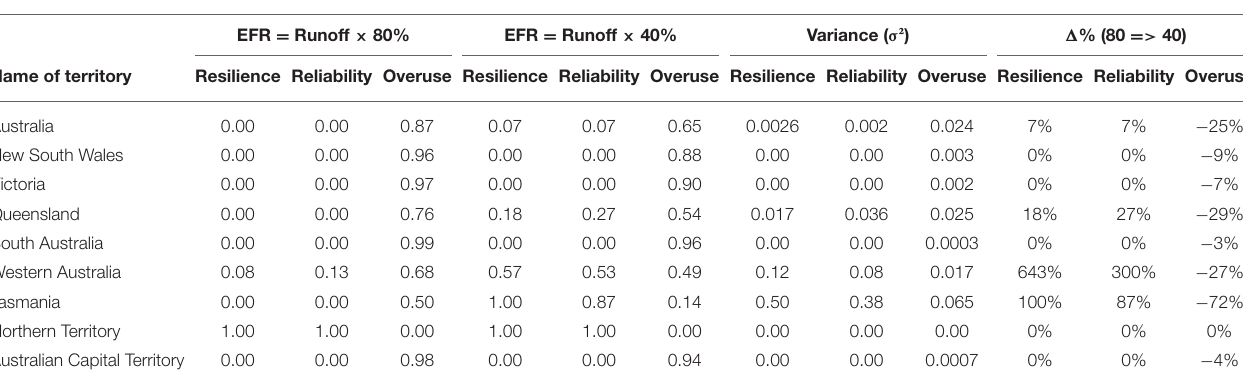
TABLE 8 | Sensitivity analysis of using the 60% of EFR for irrigation from surface